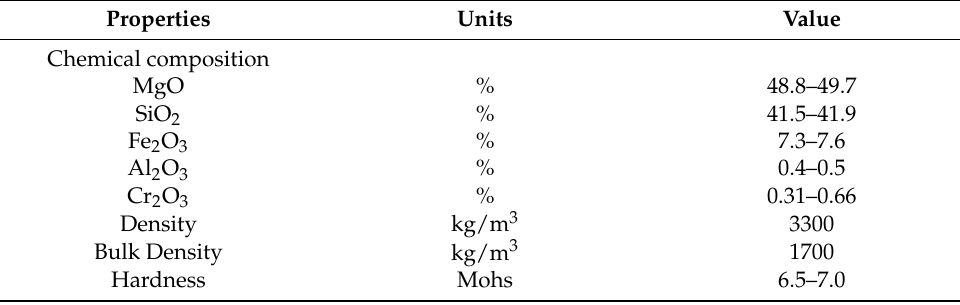
Table 3. Detailed properties of Norwegian olivine [31].